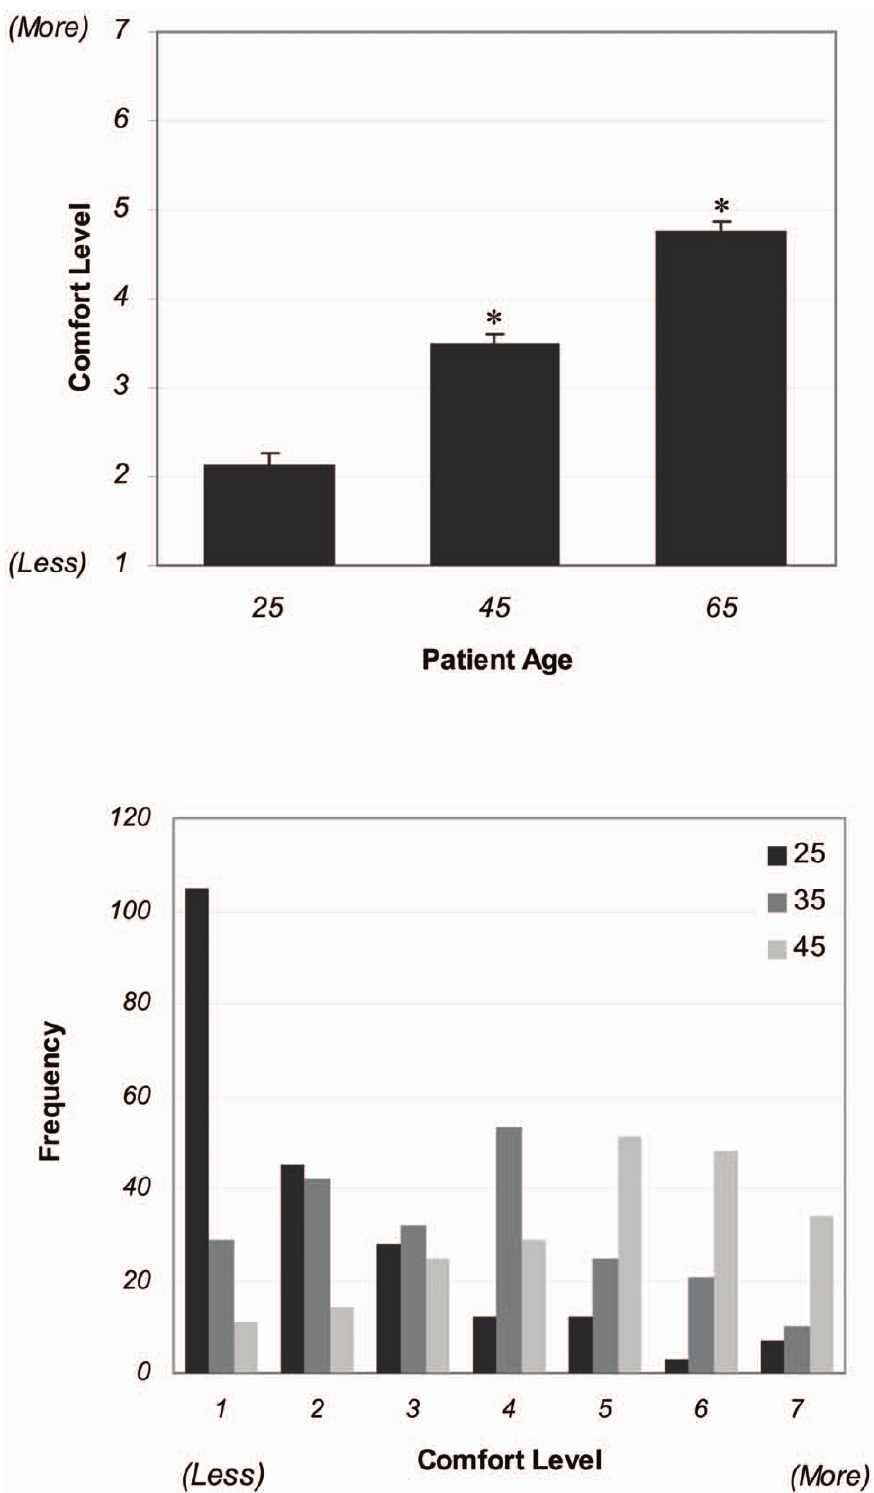
Figure 1. Physicians’ Comfort Rating with Prescribing Cognitive Enhancers to Patients of Differing Ages. (A) Mean physician comfort rating with prescribing the hypothetical cognitive enhancer to patients of differing ages. Physicians reported increasing comfort with prescribing cognitive enhancers as the patient’s age increased from 25 to 65 (P , 0.001). (B) Frequency of occurrence of each response on a 7-point Likert scale, with anchors at 1 (less comfortable) and 7(more comfortable).